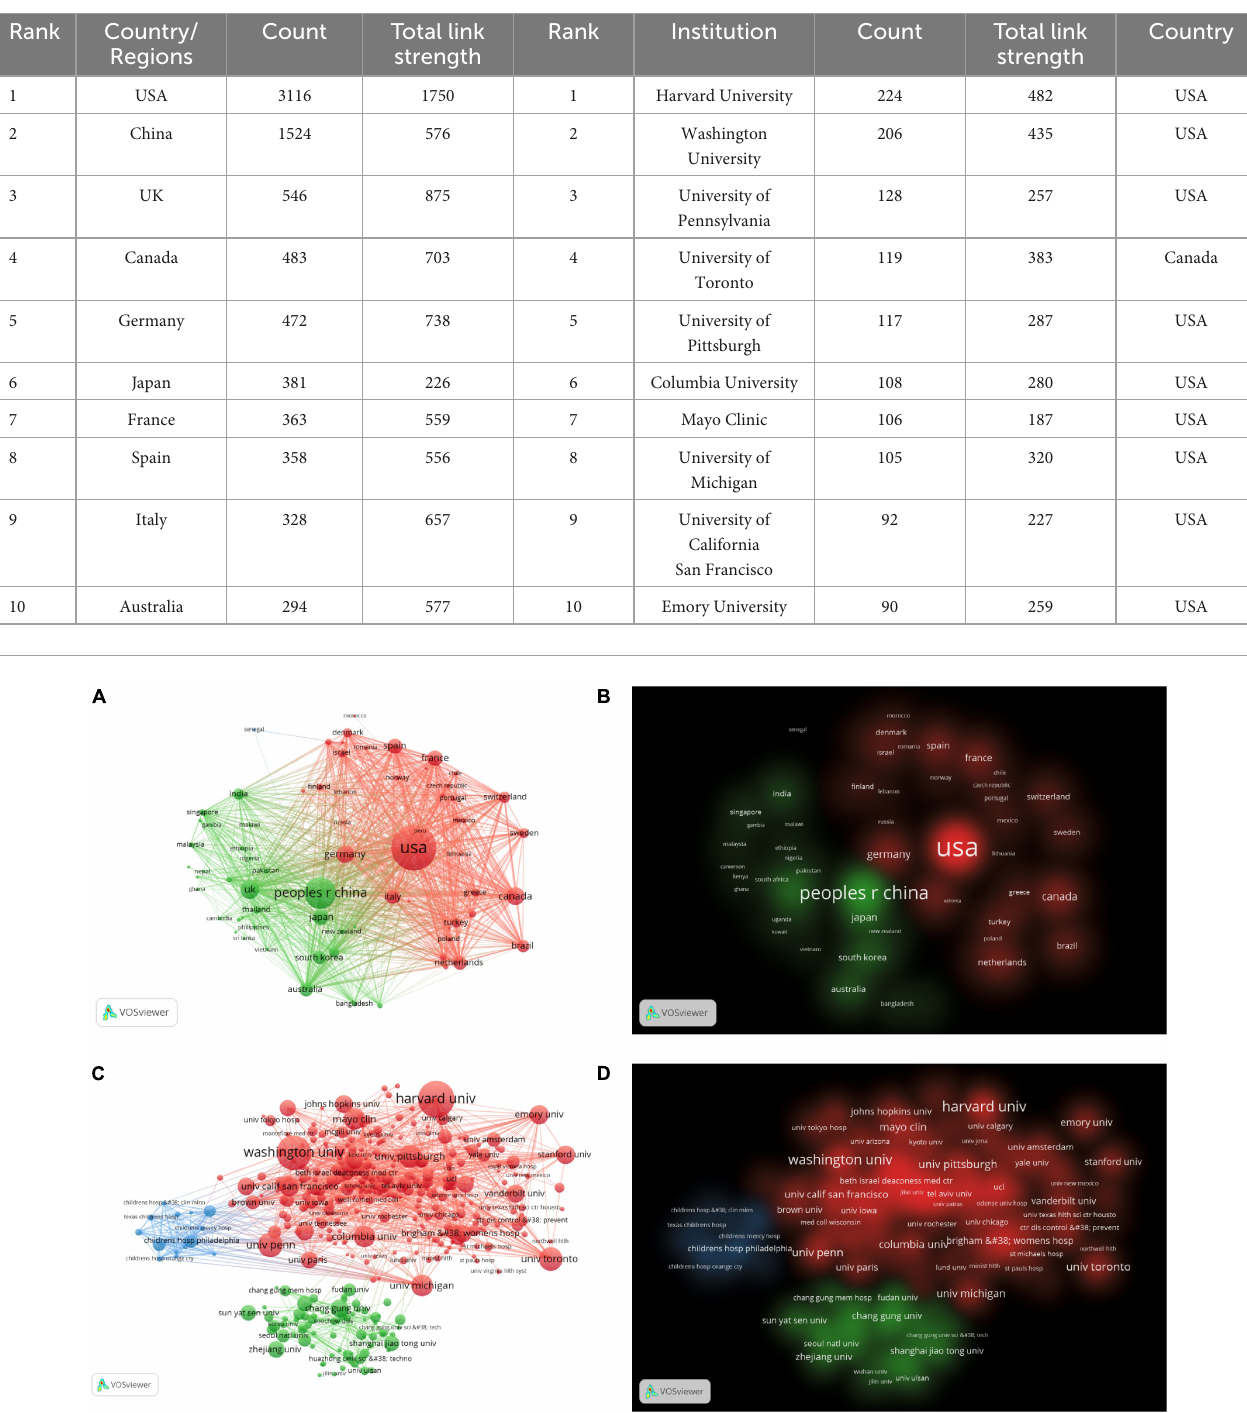
TABLE 1 The top 10 countries/regions and institutions with most publications on the application of artificial intelligence in sepsis from 2000 to 2021. Rank Country/ Regions